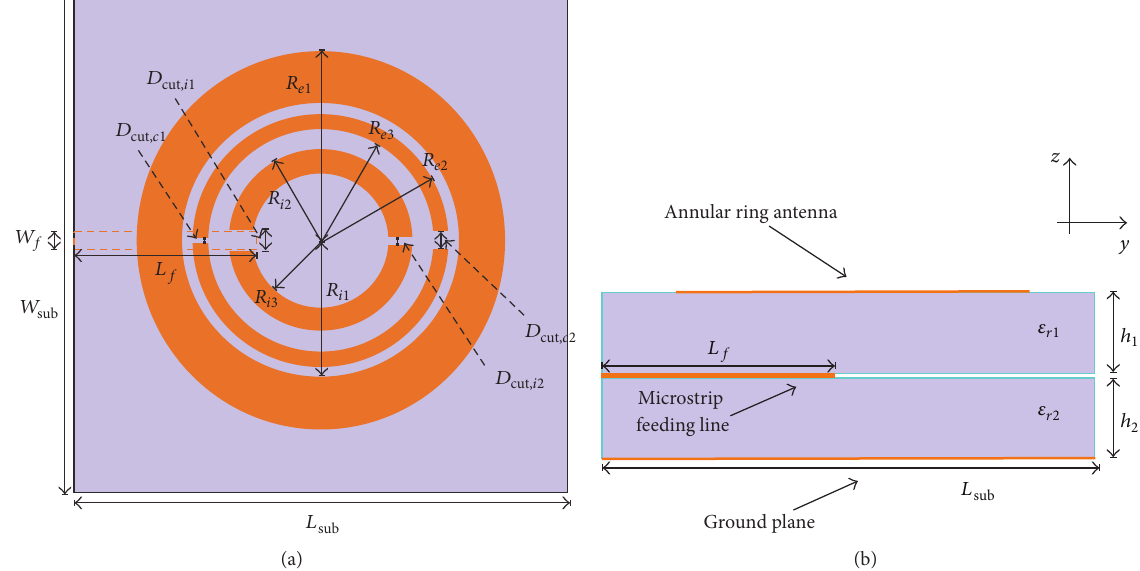
Figure 1: Antenna layout. (a) Top view; (b) side view. 𝐿 𝑅 𝑅 𝑖1 = 11.22 mm, 𝑒2 = 10.27 mm, 𝐷 = 0.5 cut ,𝑖2